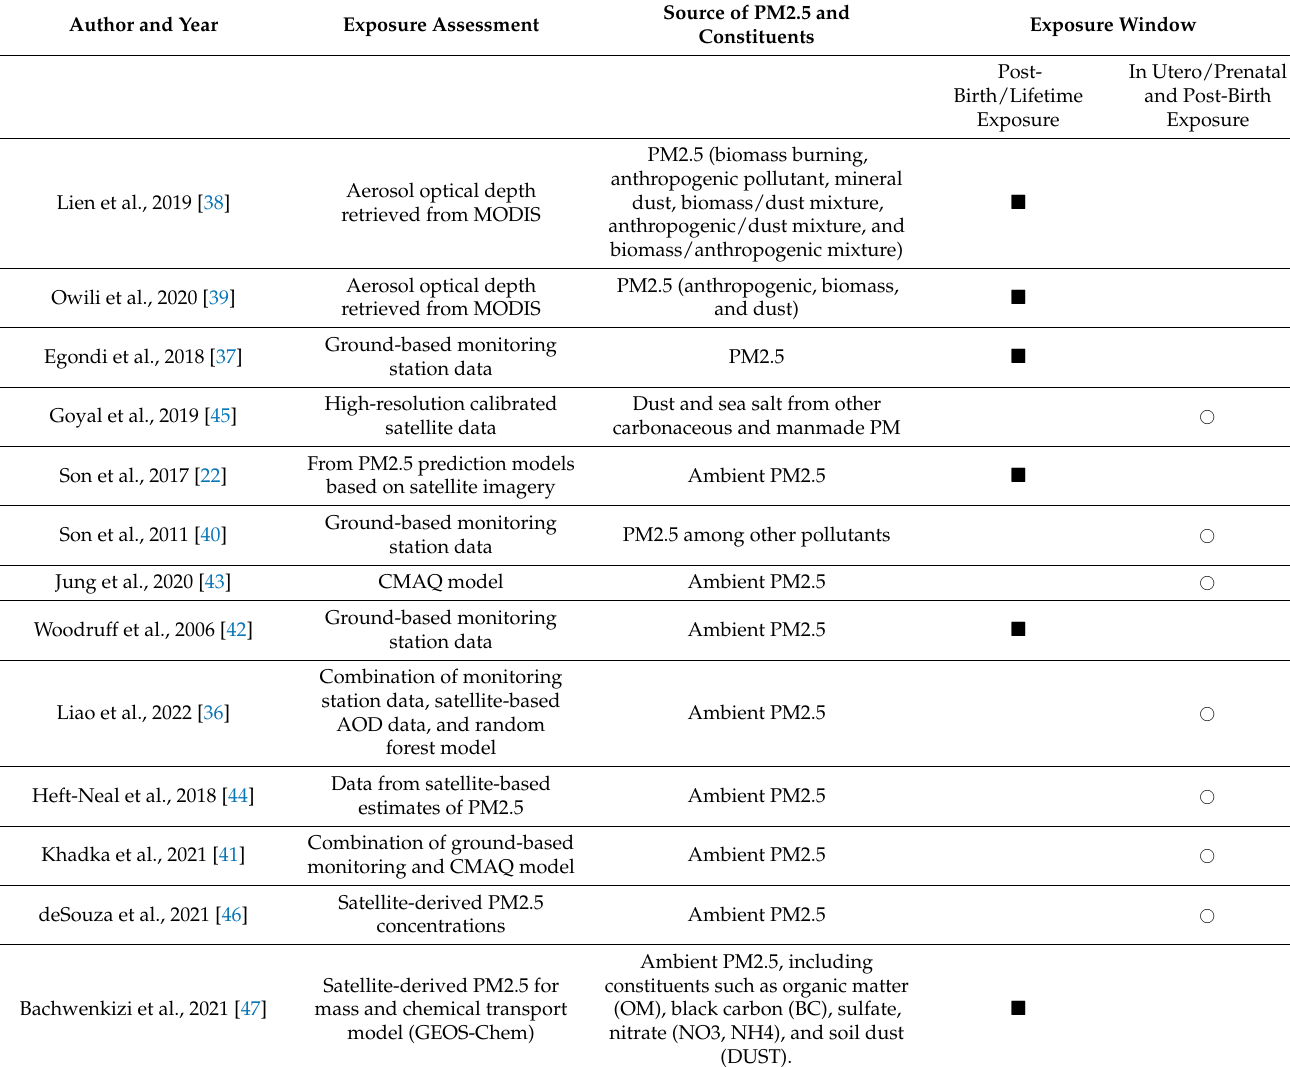
Table 3. Summary of exposure assessment in selected